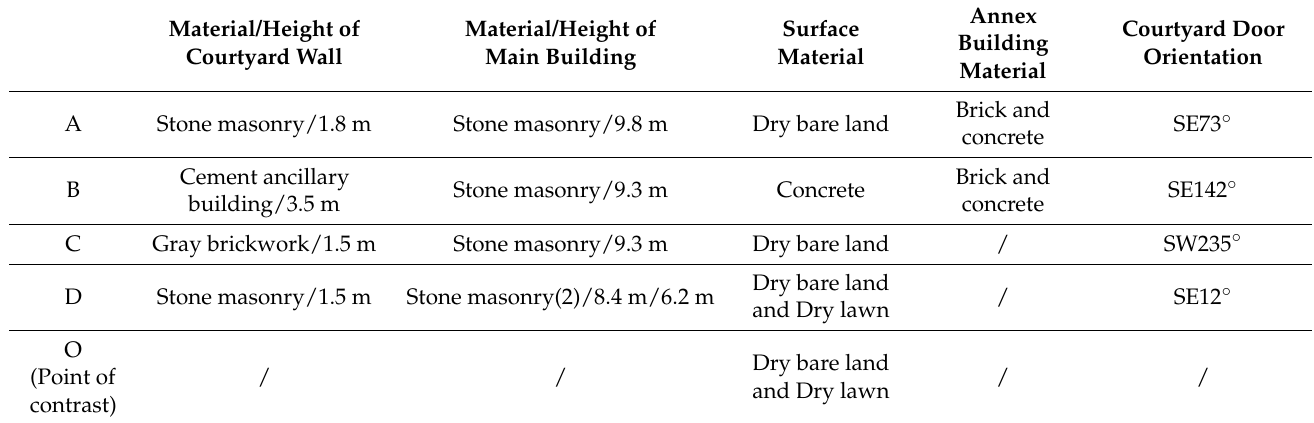
Table 1. Construction materials and details of each measuring